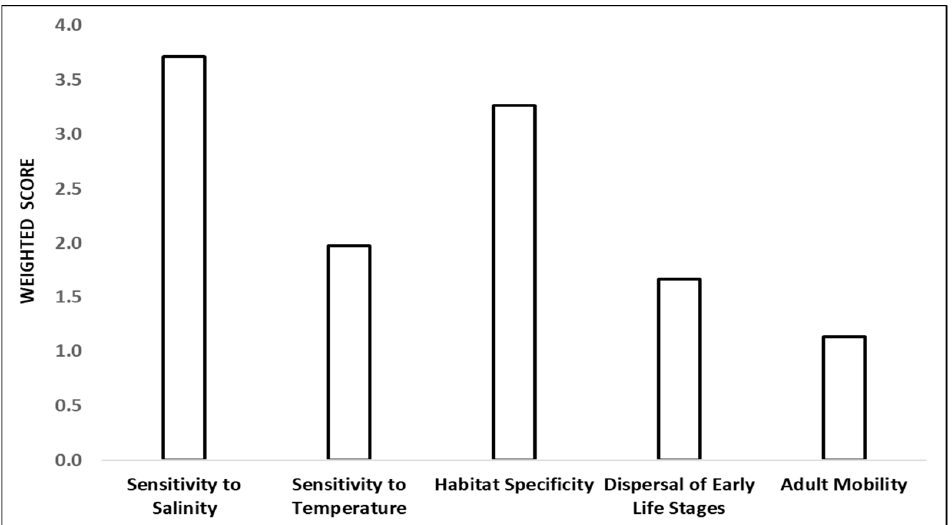
Figure 7. Average scores estimated for sensitivity attributes used in deriving potential for distribution of change of C. tulipa . Bootstrapped analysis of the scores indicates very high certainties in scores (>95%).